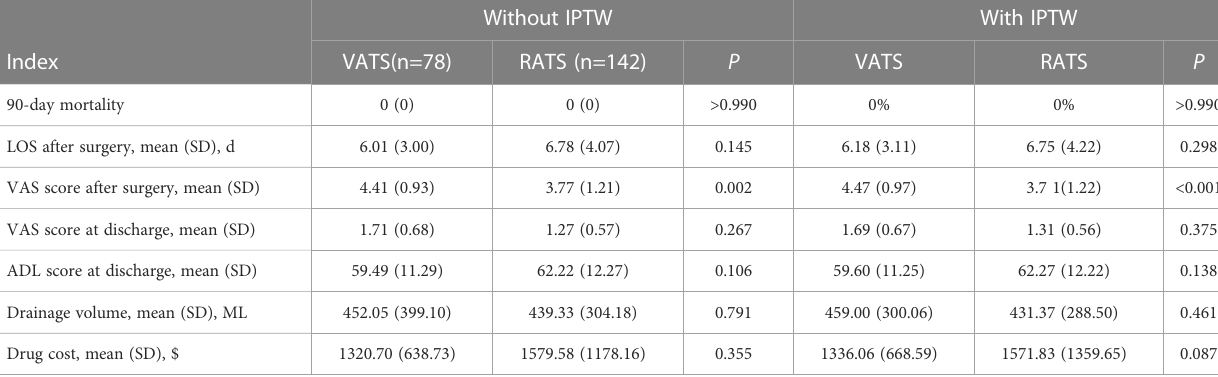
TABLE 4 Unadjusted and IPTW adjusted perioperative